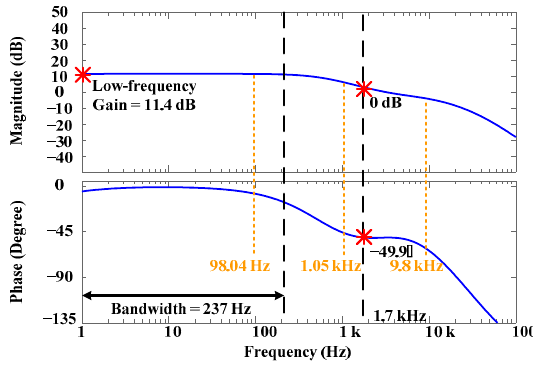
Figure 8. Bode plot simulation: G ov ( s ).